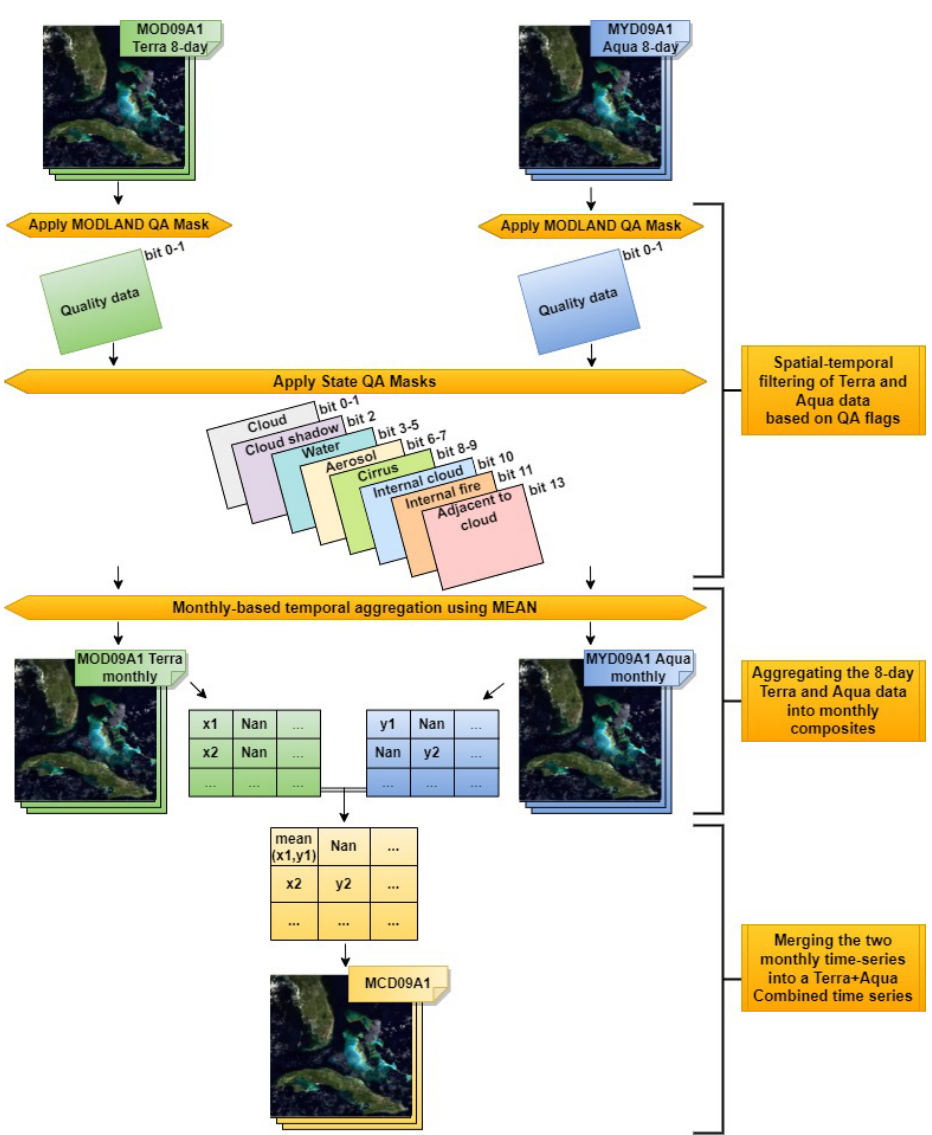
Figure 4. Description of the spatial–temporal filtering of Terra and Aqua, their aggregation into monthly composites, and their merging into Terra + Aqua combined time series. This process aims to filter out spectral values affected by disruptive conditions and to reduce the number of gaps in the multispectral time series for the 29 LULC